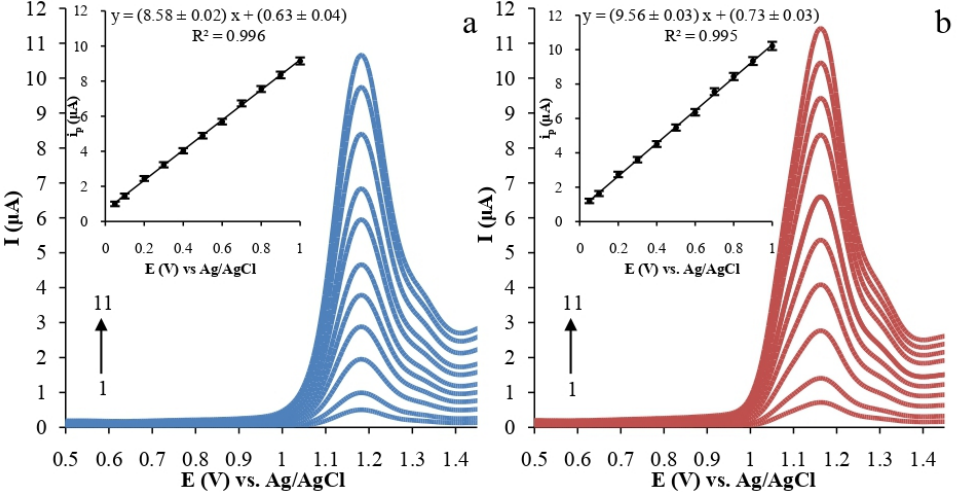
Figure 8. DPV of ( a ) R-Prp and ( b ) S-Prp solutions of various concentrations on GCE/PEC–[Zn( S -Ala) 2 (H 2 O)]–[Zn( S -Phe) 2 (H 2 O)]: 0.05 (1), 0.1 (2), 0.2 (3), 0.3 (4), 0.4 (5), 0.5 (6), 0.6 (7), 0.7 (8), 0.8 (9), 0.9 (10), 1 (11) mM (0.05 M sulfuric acid, potential scanning rate 0.2 V/s). Insets: the corresponding calibration curves.